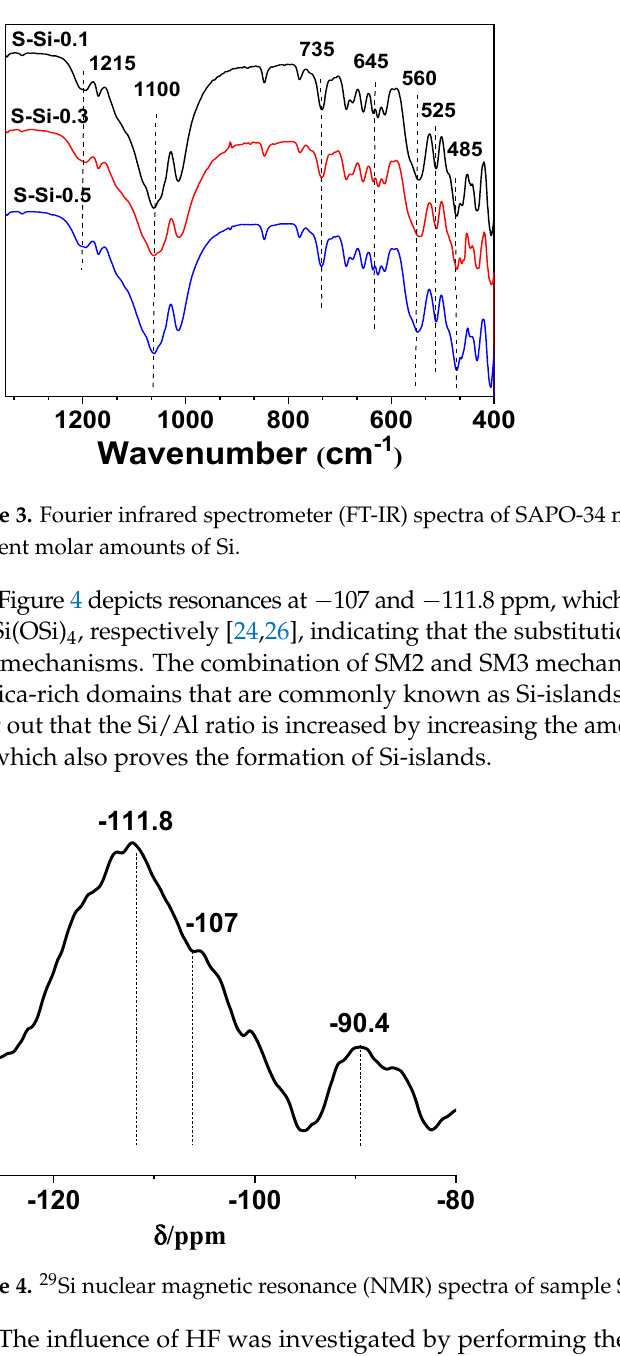
Figure 4. 29 Si nuclear magnetic resonance (NMR) spectra of sample S-Si-0.3.